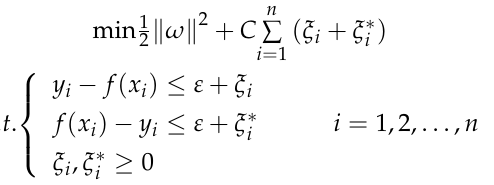
Figure 2. Schematic diagram of each reference coordinate frame. The green line represents the nav- igation coordinate frame, the red line represents the carrier coordinate frame, and the blue line rep- resents the DVL device coordinate frame.